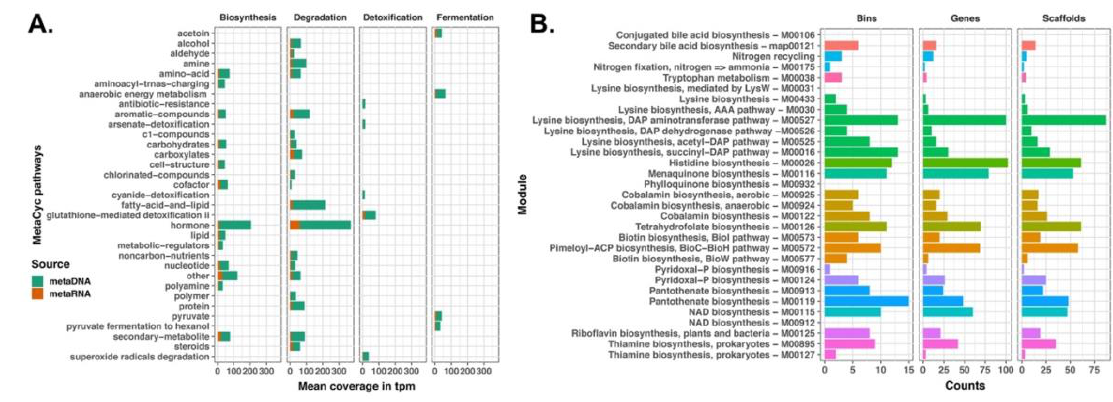
Figure 8. Overview of X. tropicalis tadpole's microbiota metabolic functions. A. This barplot represents the read coverage (x-axis, in transcripts per kilobase million) on genes encoding enzymes participating in various Metacyc pathways (y-axis). B. Counts of metagenome bins, genes and scaffolds